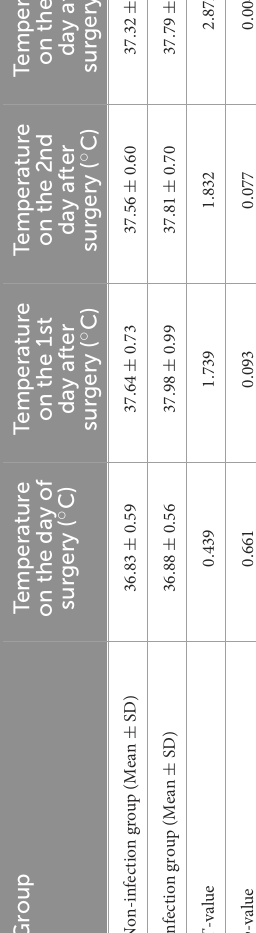
low glucose content in CSF is of high diagnostic and predictive value for intracranial infections caused by specific bacteria. The change in CSF glucose content is more effective than CSF WBC count for detecting intracranial infection. A prospective study by Pedro Grille et al. (22) showed that CSF glucose and lactic acid had the best diagnostic accuracy for ventriculostomy-related infection, with an AUC of 0.951 and 0.900 ( p = 0.001), respectively. CSF WBC count and protein level were not able to diagnose ventriculostomy- related infection better than CSF glucose and lactic acid. Tavares et al. (23) conducted a prospective study on 28 neurosurgical patients and found that CSF glucose level is better than leukocyte count and protein index for the diagnosis of intracranial infection. Eduardo et al. (10) found that the sensitivity of 3 mmol/L CSF lactic acid to bacterial meningitis was 95%, the specificity was 94%, and the negative predictive value was 99.3%. A prospective study conducted by Maskin et al. (24) also drew a similar conclusion that the increase of cerebrospinal fluid lactic acid has a better predictive value in the diagnosis of intracranial infection than the increase of the number of cells in cerebrospinal fluid. When the level of CSF lactic acid is ≥ 4 mmol/L, the sensitivity and specificity of the diagnosis of intracranial infection are 97 and 78% respectively. Two other meta- analyses pointed out that the accuracy of cerebrospinal fluid lactic acid in the diagnosis of intracranial infection was better than other indicators in cerebrospinal fluid (25, 26). Therefore, the content of glucose and lactic acid in cerebrospinal fluid has high